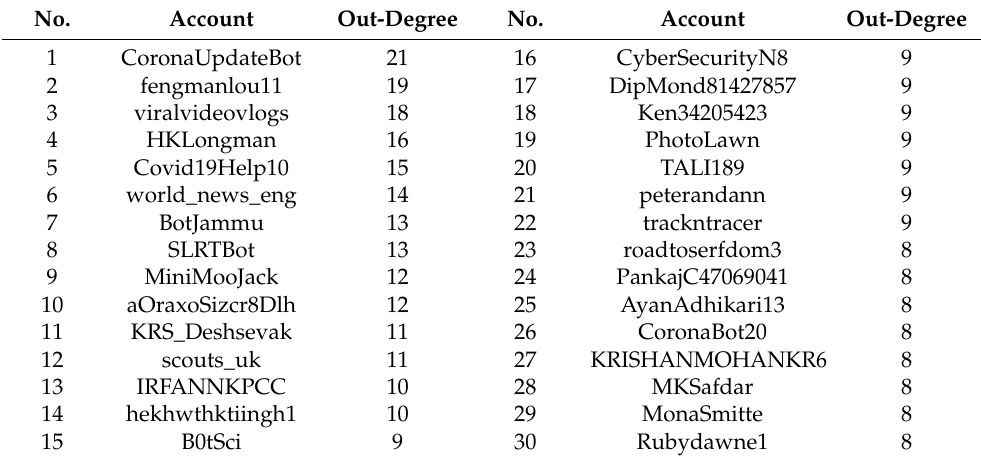
Table 5. Top 30 Twitter accounts by